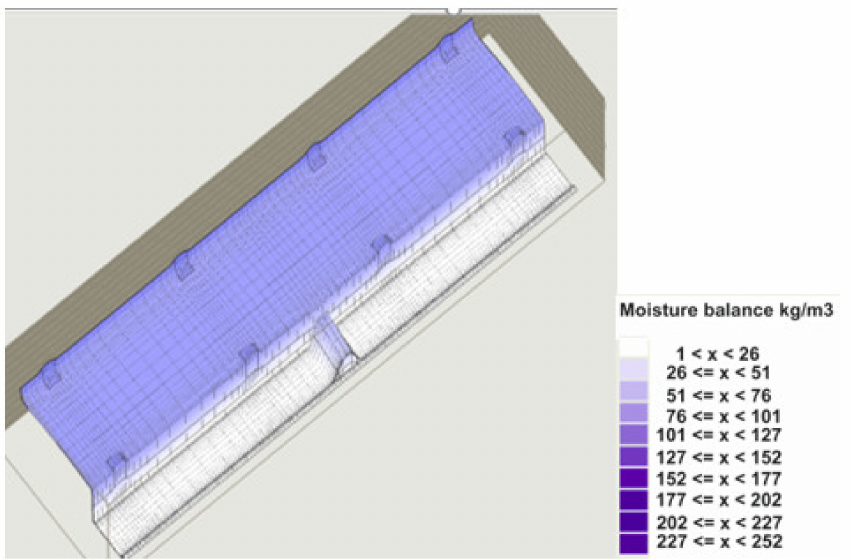
Figure 29. Wall insulated with light aerated concrete—completion time (3